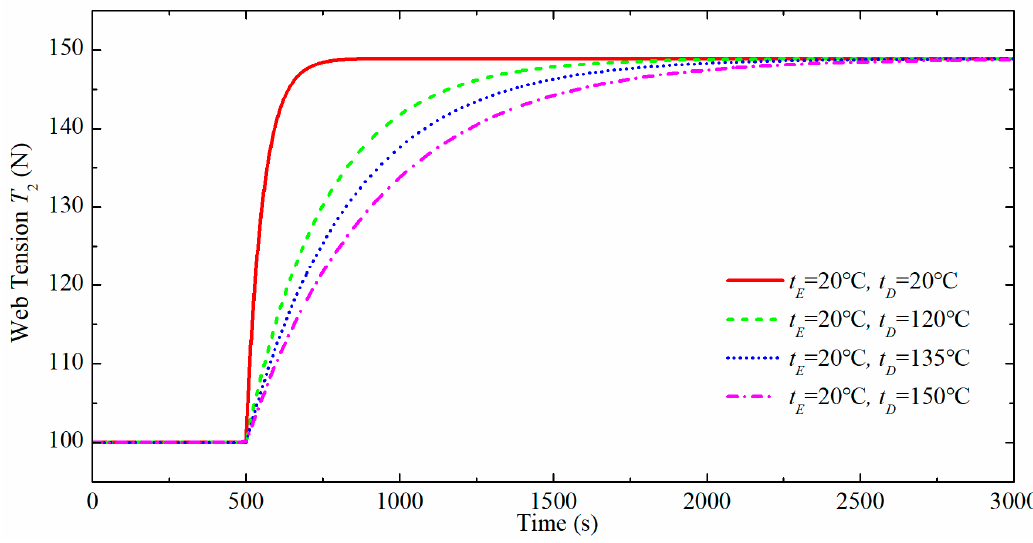
( ) T t as ( ) v t has step changes at different drying temperatures 2 2